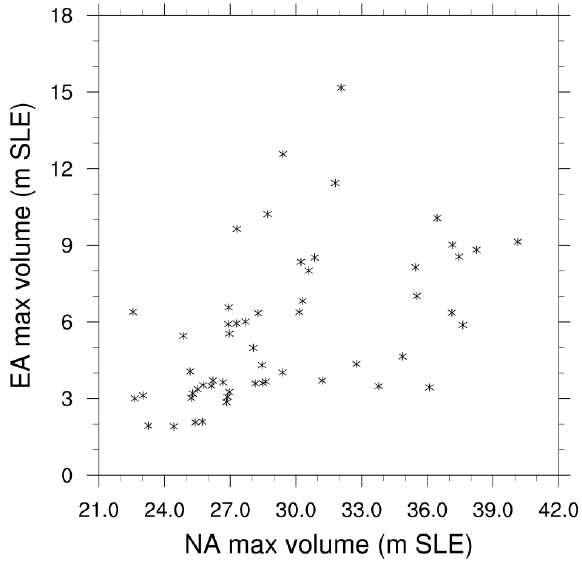
Figure 10. The maximum volume of the NA and EA ice sheets for individual